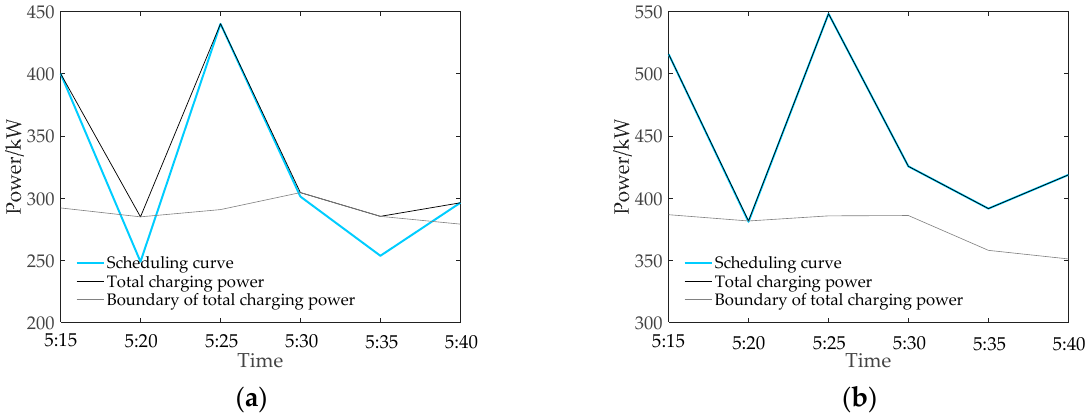
Figure 16. Comparison of results responding to the EVs in V2G mode and G2V mode in emergency